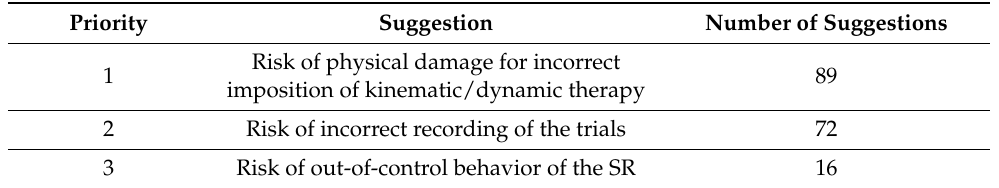
Table 13. Suggestions on the cyber risk to face.